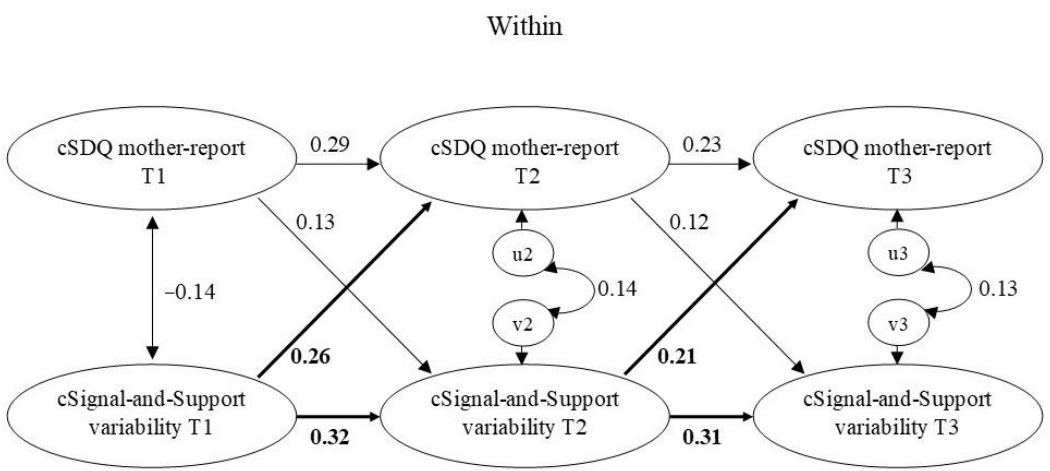
Figure 5. Within-level model for SDQ mother report and Signal-and-Support variability. Standardized estimates are presented. Significant effects are in boldface. c = within-person centered; SDQ = Strengths and Difficulties Questionnaire, total problems scale.